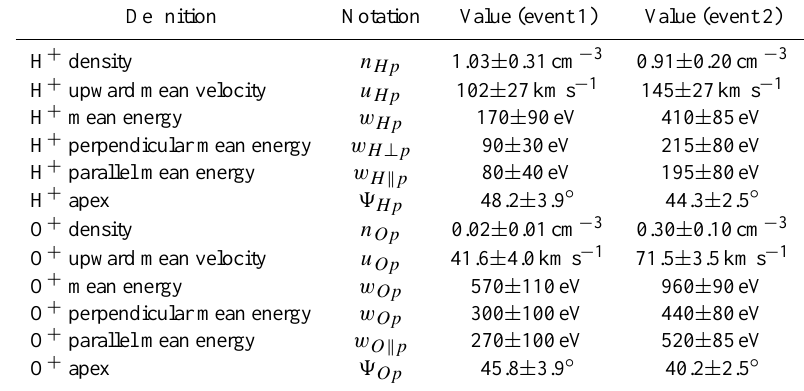
Table 1. List and values of H + and O + moments associated with the observed conics at the poleward heating boundary during events 1 and 2